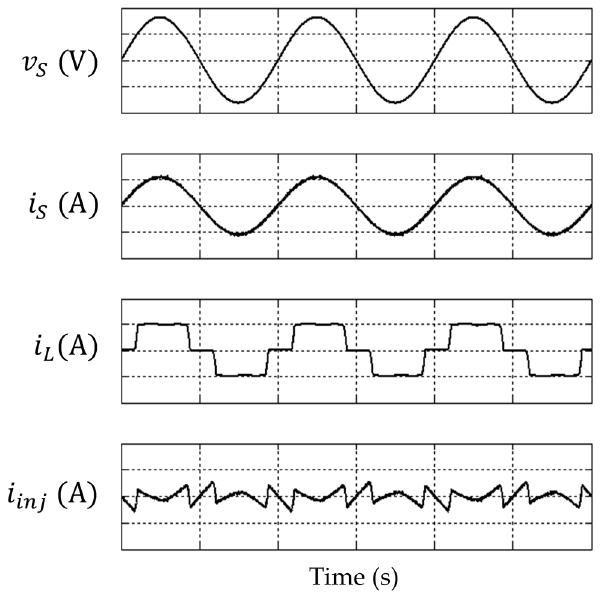
Figure 2. Theoretical waveforms (phase A) of a SAPF’s operation.